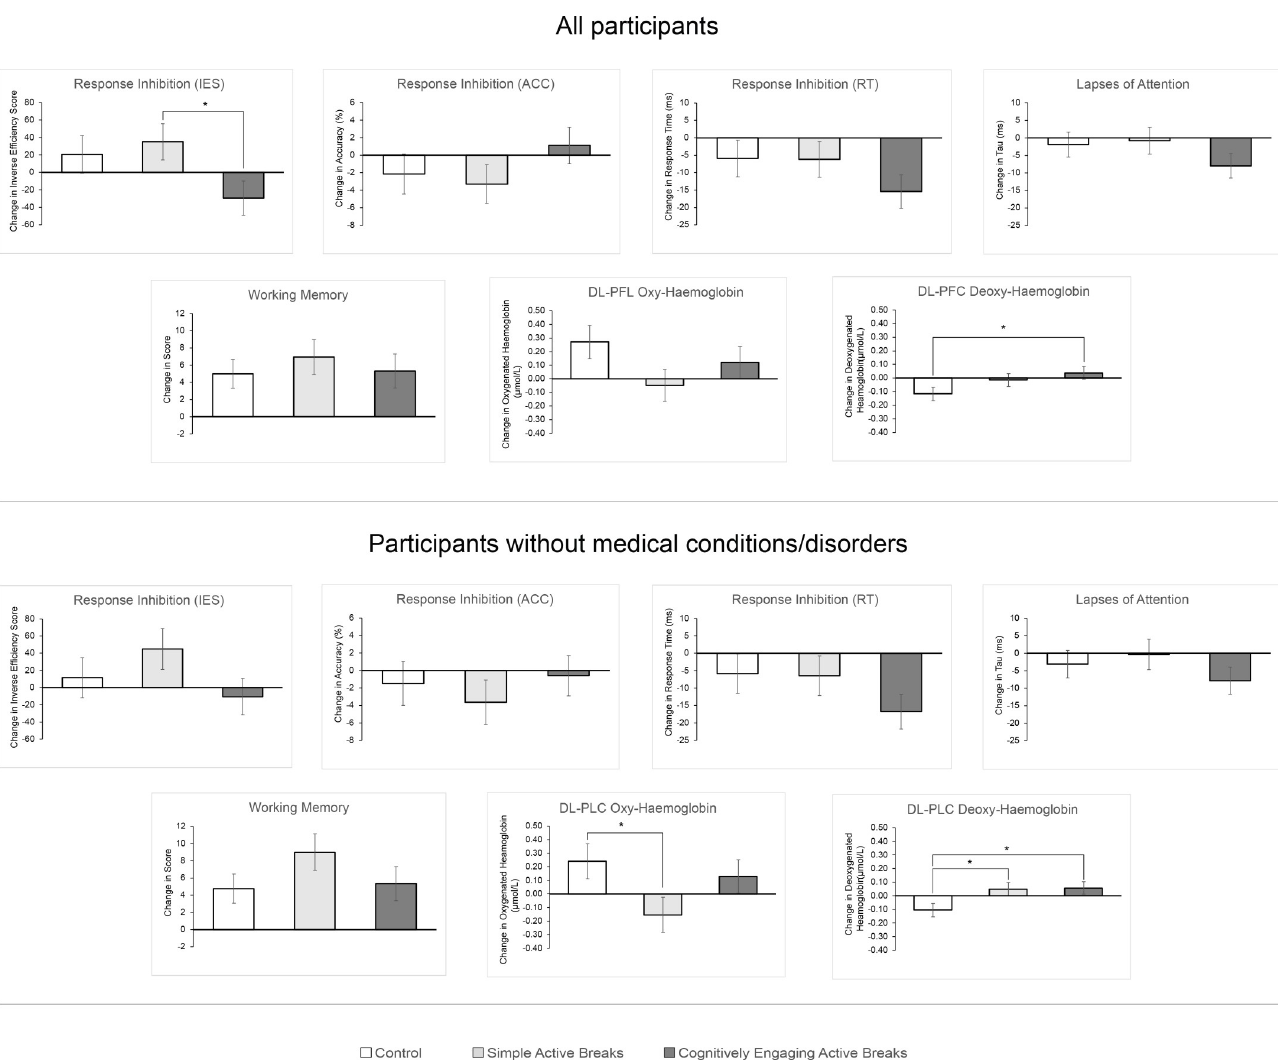
Fig 4. Effects of cognitively engaging and simple active breaks, and usual school practice, on children’s cognitive functions and left dorsolateral prefrontal cortex haemodynamic response. The graph shows the adjusted marginal change score means ± standard error for each study group—for the entire sample and for children who were not reported to have a medical or developmental condition. Inverse efficiency score (IES); response time (RT); accuracy (ACC); dorsolateral prefrontal cortex